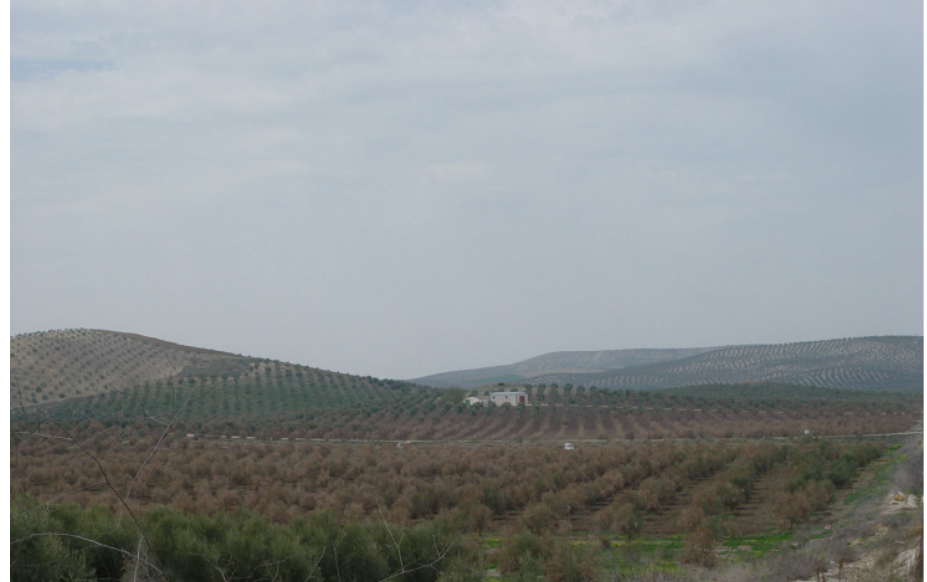
Figure 1. Consequences of an agricultural planning that does not take into account bioclimatol- ogy. Olive grove damaged by frost in 2005 due to being located in an enclosed valley affected by temperature